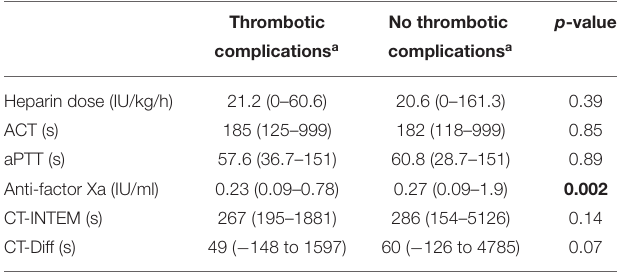
TABLE 5 | Comparison of the median values from heparin dose and coagulation TABLE 3 | Comparison of the median values from heparin dose and coagulation assays in the presence and absence of disseminated intravascular coagulation. assays in the group of patients with and without thrombotic complications. Thrombotic No thrombotic p -value DIC